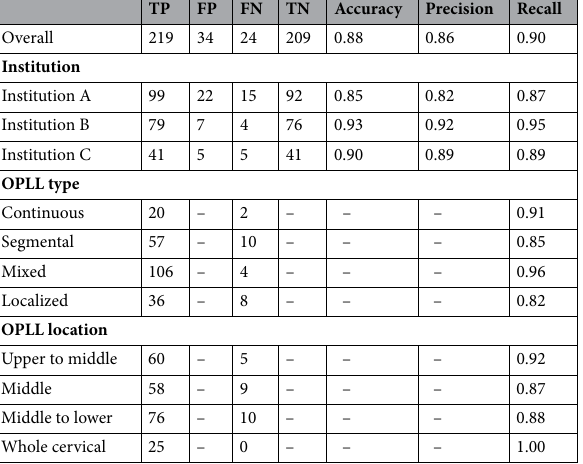
Table 2. Diagnostic results of the deep learning algorithm (n = 486). TP, true positive; FP, false positive; FN, false negative; TN, true negative; OPLL, ossification of the posterior longitudinal ligament.